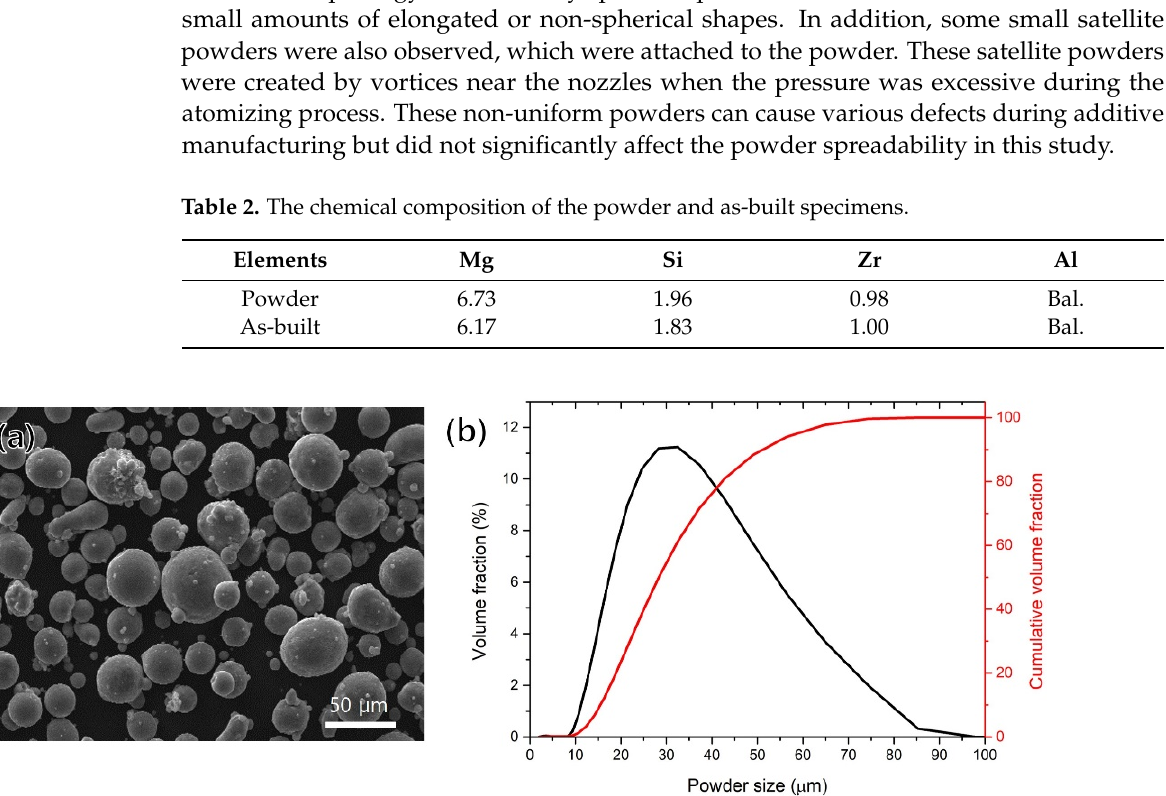
Figure 2. ( a ) SEM image of the powder morphology, ( b ) distribution of particle size. Table 2. The chemical composition of the powder and as-built specimens.